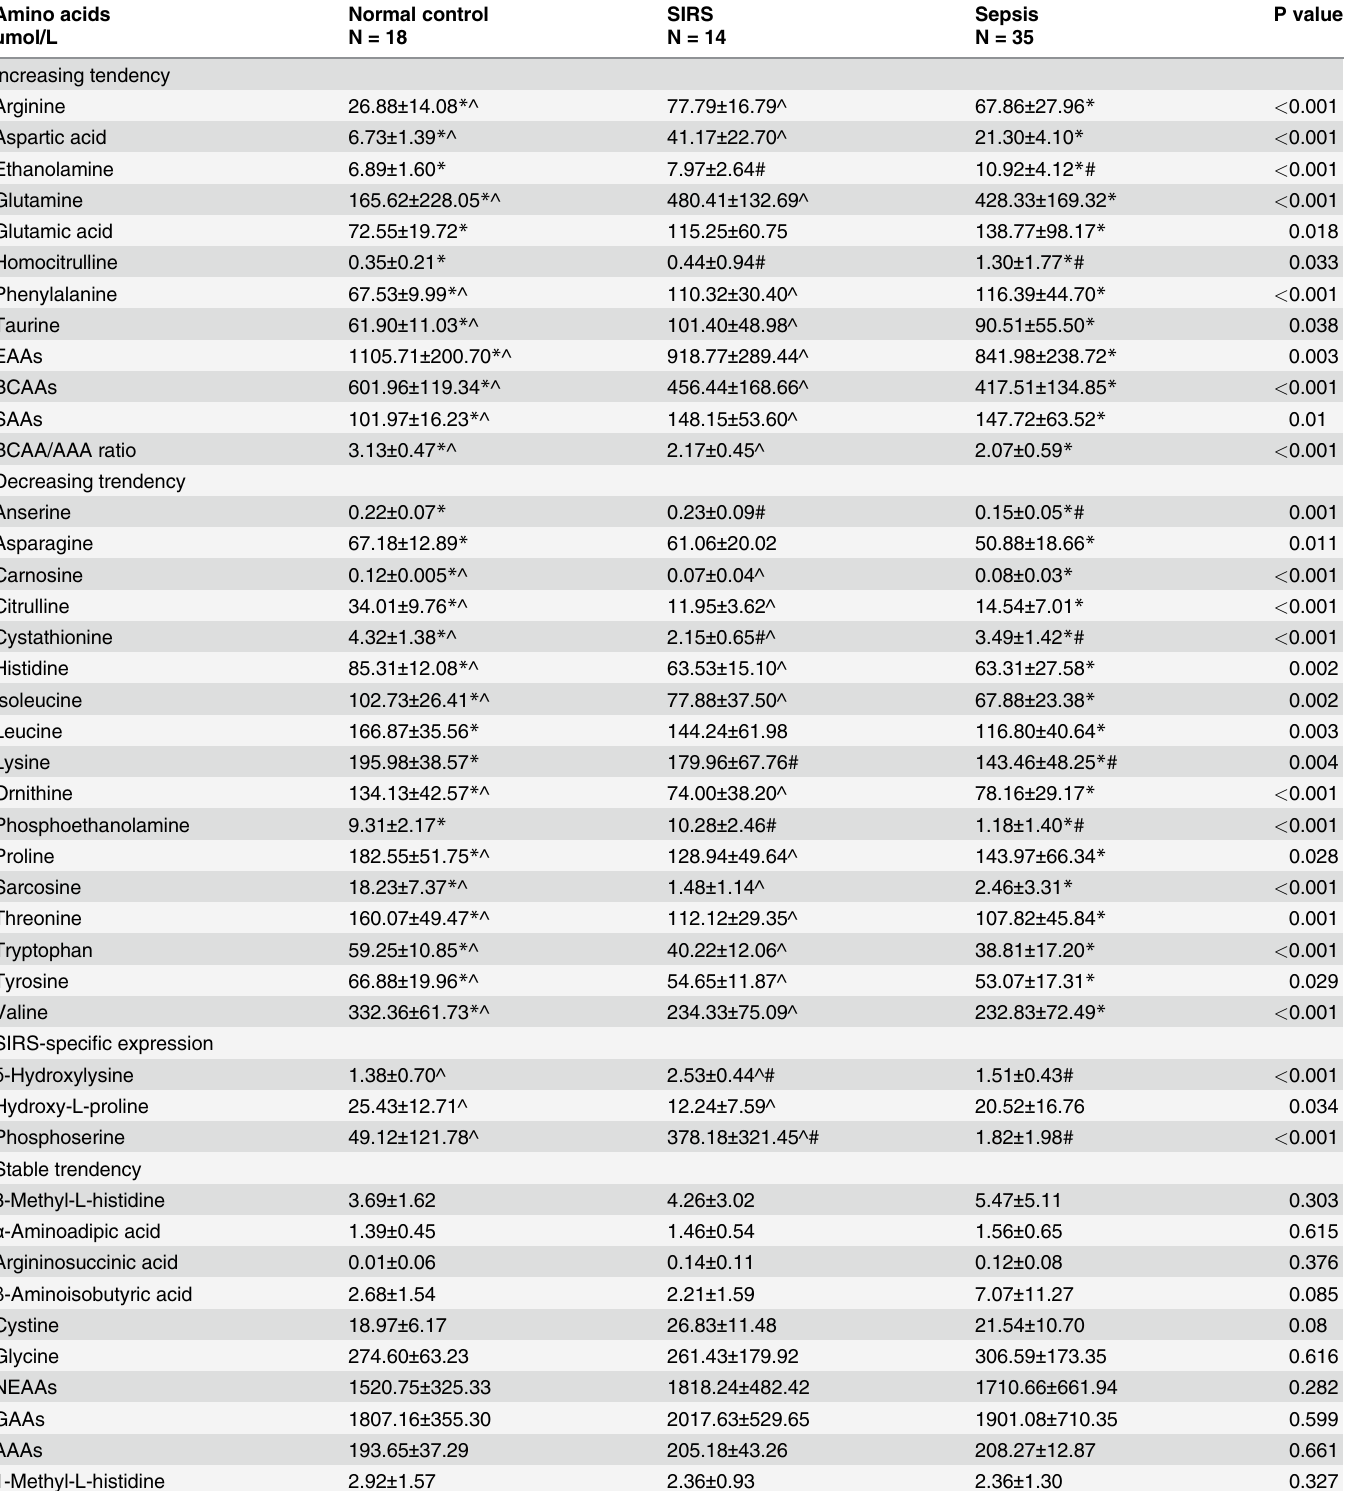
Table 2. Comparison of amino acid serum concentrations among the normal control, SIRS, and sepsis groups on the day of ICU admission. Amino